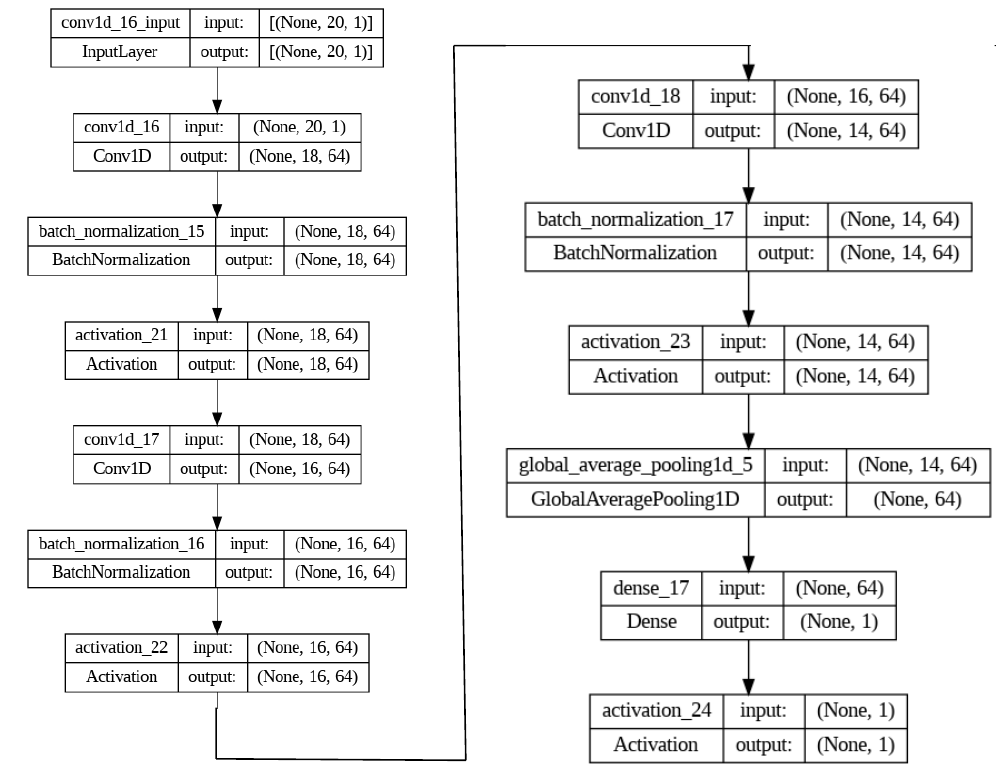
Figure 5. The proposed DNN architecture with a total number of 25,793